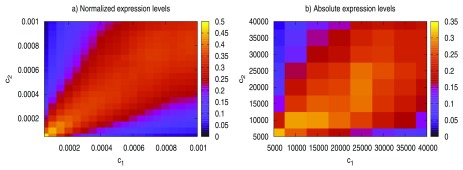
We evaluated the agreement between the two
Drosophila datasets in terms of the transitioning genes assigned to each stage-pair, considering only those genes that appear in both datasets.Because the appropriate transition threshold may be different at each dataset, we use a different threshold for each dataset, say
c
1 and
c
2. For each pair (
c
1,
c
2), we determine the transitioning genes at each stage-pair with the corresponding dataset.,
L − 1 pairs of gene sets), and then calculate the average Jaccard similarity across these
L − 1 pairs. The Jaccard similarity maps show this average across all stage-pairs for various threshold pairs (
c
1,
c
2). In graph (
a) with normalized expression levels, when the two thresholds are roughly equal, the average Jaccard similarity is as high as 50%; this means that about 2/3 of the genes assigned to a certain stage-pair using one dataset are also assigned to the same stage-pair using the other dataset. Graph (
b) shows a similar Jaccard similarity map for the case of absolute expression levels. [Dataset 10].